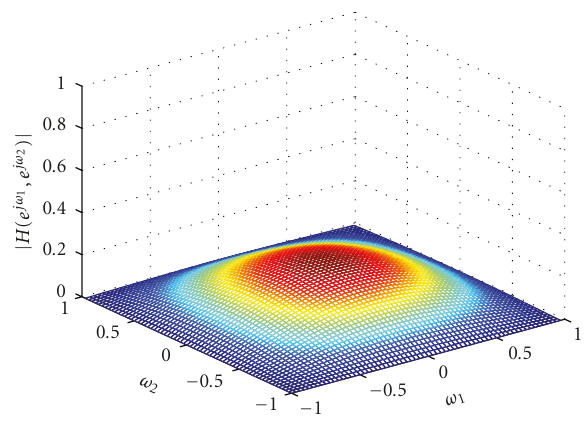
Figure 7: Plot of the error in magnitude